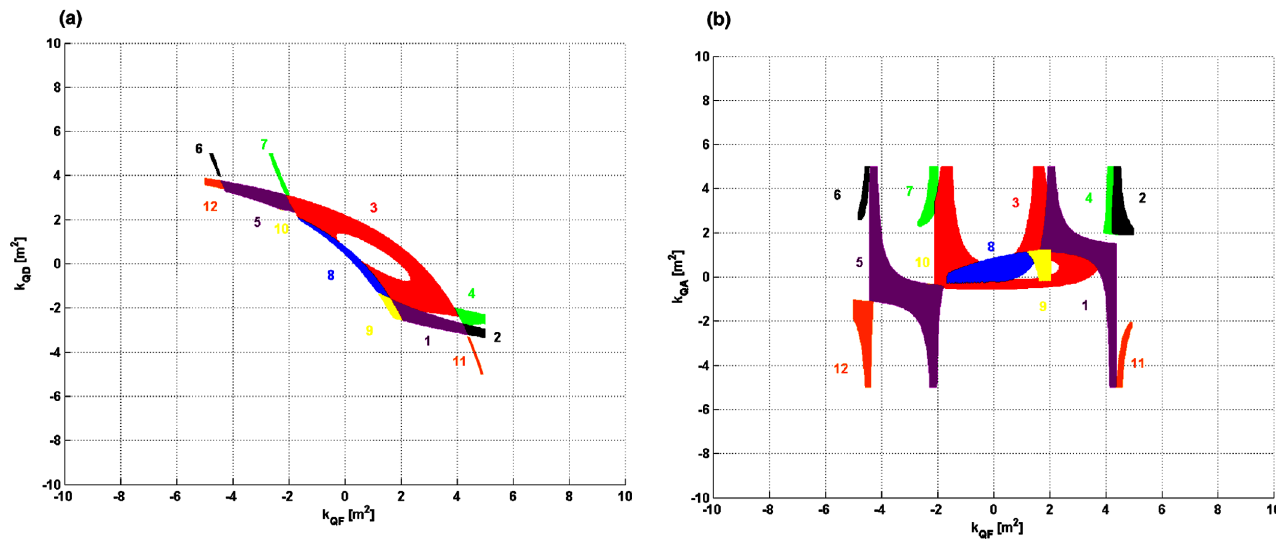
FIG. 14. (Color) k -space data shown in Fig. 13 is shown from two different perspectives—projecting on the kQF and kQD axis (left) and projecting on the kQF and kFA axis